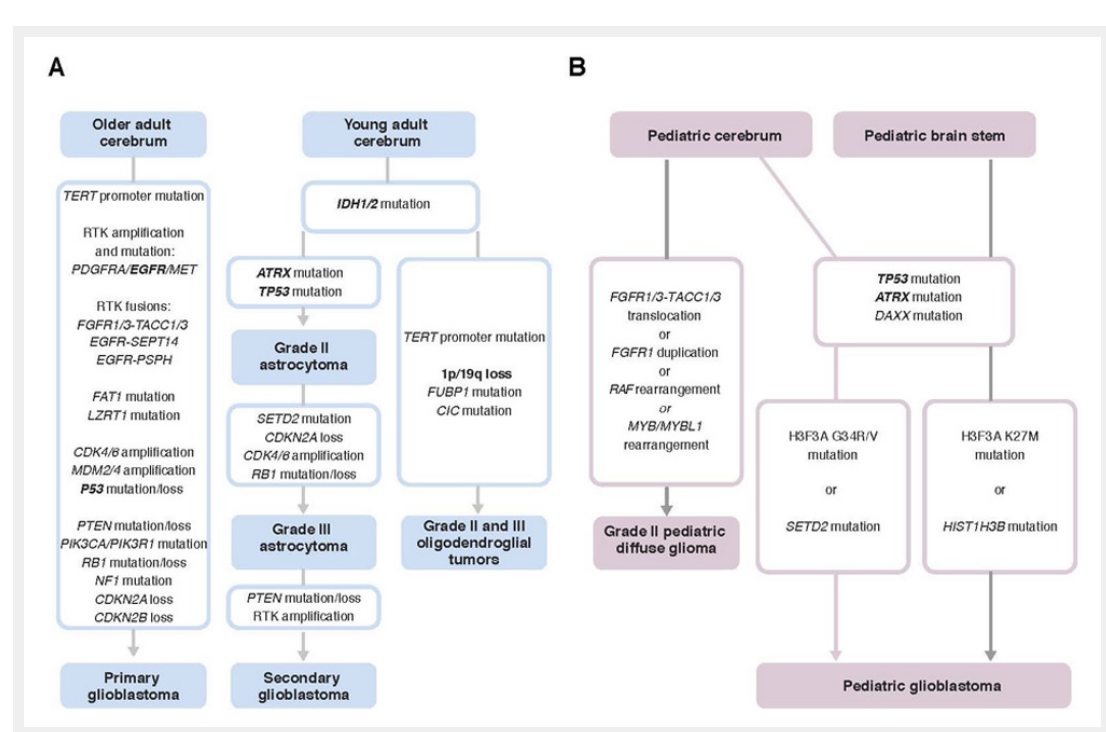
Genomic alterations underlying the development of gliomas. (A) Gliomagenesis in adults. Secondary glioblastomas (10% of cases) affect younger individuals and develop over a long period of time from lower-grade astrocytomas. Almost all cases are characterised by a mutation in IDH1/2, and a majority has mutations in ATRX . Primary glioblastomas (90% of cases) occur in older individuals and do not have a known precursor lesion. Almost all cases are wild-type for IDH1/2 and ATRX . Oligodendrogliomas are characterised by mutations in IDH1/2 , wild-type ATRX , and loss of 1p/19q. (B) Paediatric gliomagenesis is molecularly distinct. Low-grade tumours are characterised by a single genetic event affecting FGFR, MYB/MYBL1 or RAF . Paediatric glioblastoma hallmark mutations target H3F3A at different residues, depending on tumour location. See text for gene abbreviations. In bold are highlighted proteins routinely tested to guide diagnosis. In addition to this, MGMT promoter methylation is frequently tested for therapeutic decisions (see text). Larger panels of genetic mutations are screened in clinical